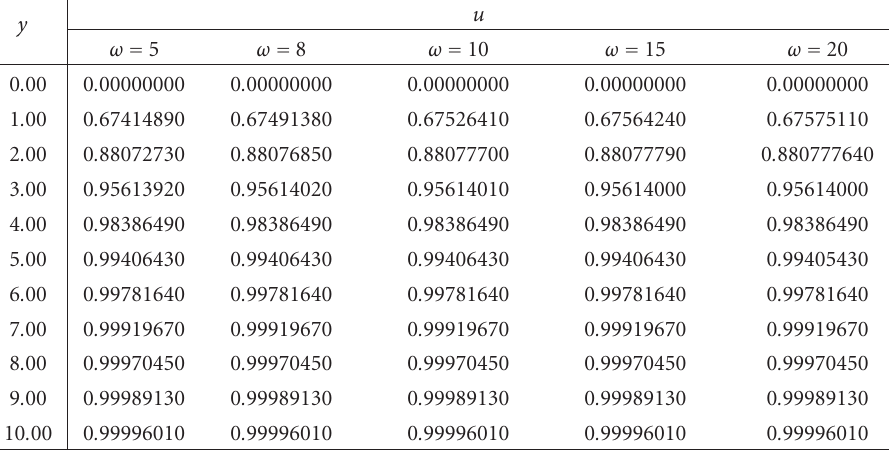
Table 4.1. Main velocity u for Gr = 5 . 0, Pr = 7 . 0, S = 1 . 0, and z = 0 . 2.